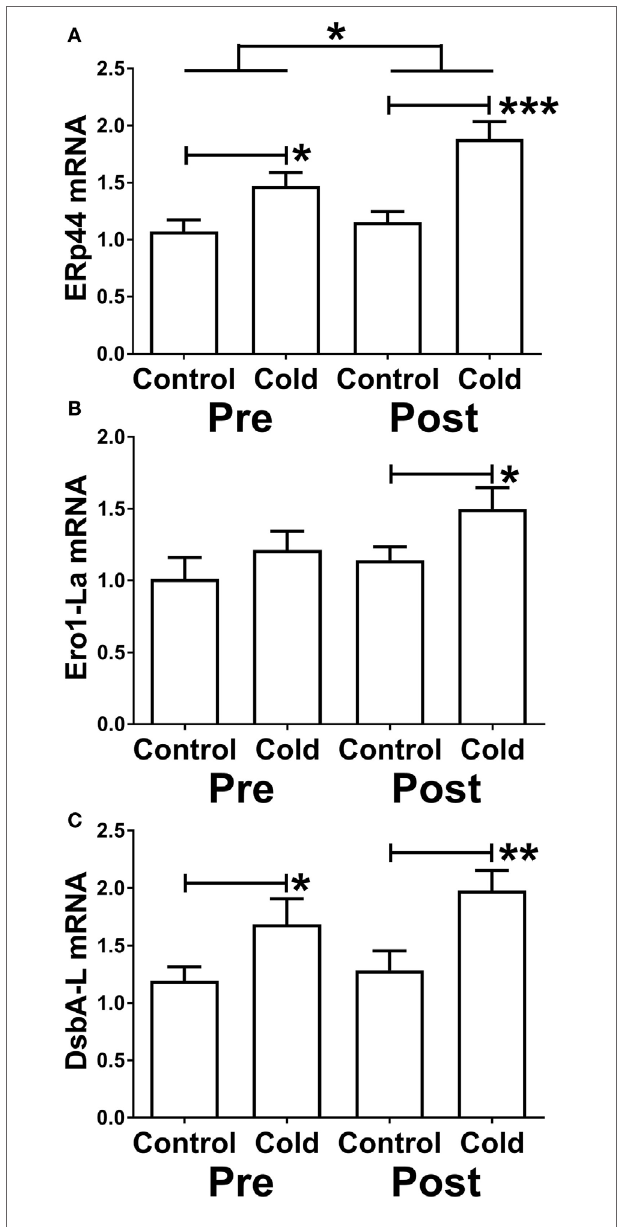
FiGUrE 5 | Effect of KDT501 and cold on the expression of genes that regulate adiponectin secretion and multimerization. (a–C) Gene expression was measured by real-time reverse transcriptase polymerase chain reaction as described in the Section “Materials and Methods.” Data represent the mean ± SEM ( n = 9); data in all panels were analyzed by a repeated measures analysis of variance (* P < 0.05; ** P < 0.01; *** P < 0.001). The data in all panels were also analyzed by a paired, two tailed Student’s t -test of the change in gene expression by cold before and after KDT501 treatment (ERp44: * P < 0.05).